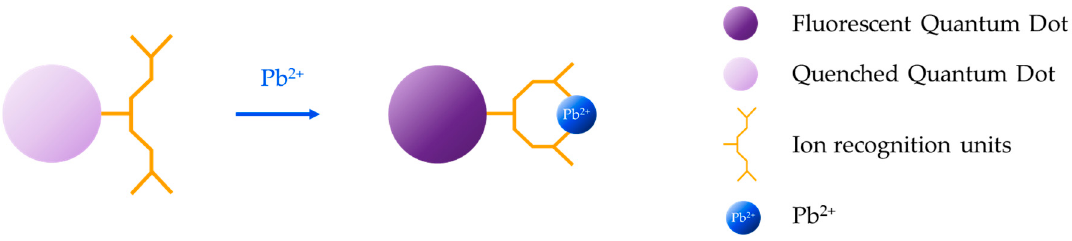
Figure 11. Sensing mechanism based on organic dyes modified with an ion recognition unit: the interaction between the ionophore and the target analyte induces a change in the fluorescent emission of the fluorophore.